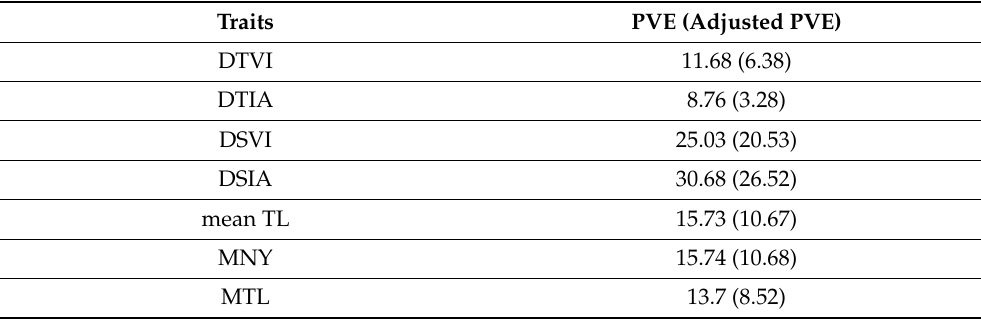
Table 3. The phenotypic variance explained (PVE) (adjusted PVE) by accumulative 27 significant SNP markers across all analyses for each